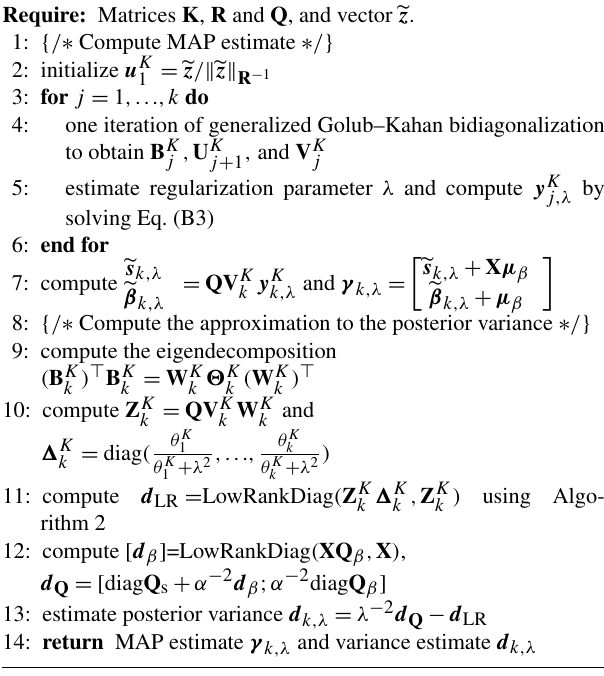
Algorithm B1 AIM with unknown mean – genHyBRmean with